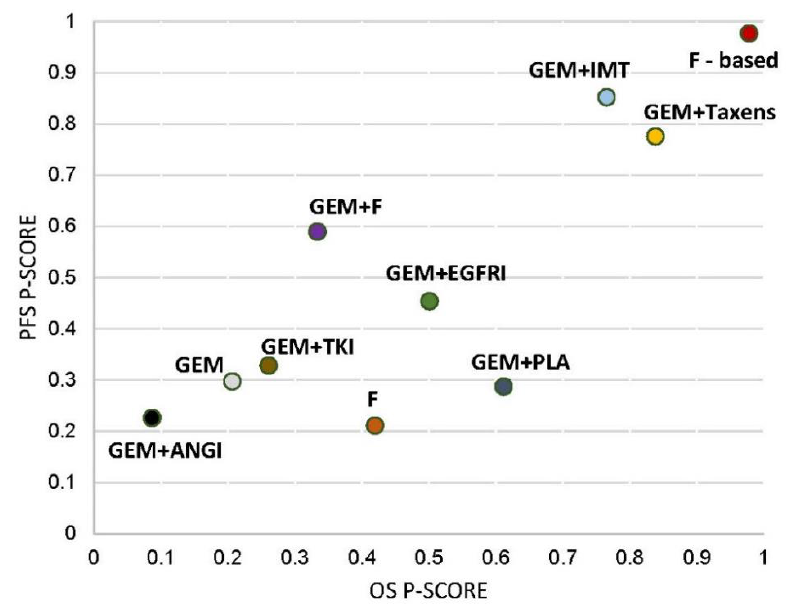
Figure 3. P-scores ranking plot. P-scores ranking plot represented the overall survival and the progression-free survival of interventions for advanced-staged pancreatic cancer. Treatment with best e ffi cacy should be in the right-upper corner of the graph. PLA: doublet platinum-based treatment; GEM: gemcitabine; F: fluoropyrimidine only; F-based: fluoropyrimidine-based treatment; EGFRI: epidermal growth factor receptor inhibitor; ANGI: angiogenesis inhibitor; IMT: immunotherapy; TKI: tyrosine kinase inhibitor.